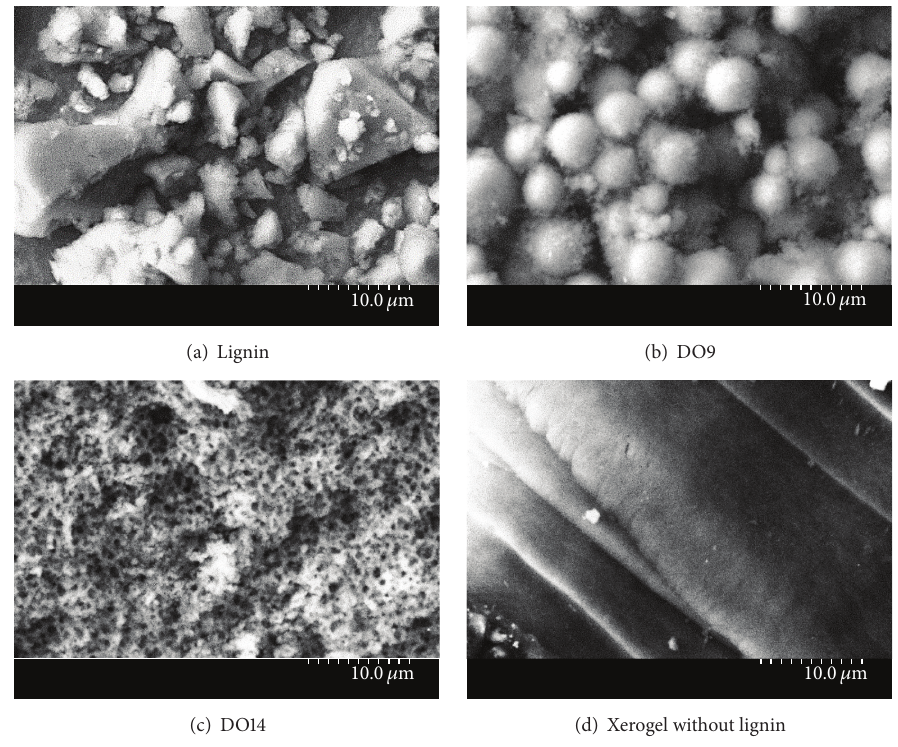
Figure 12: Some SEM micrographs (3000x).